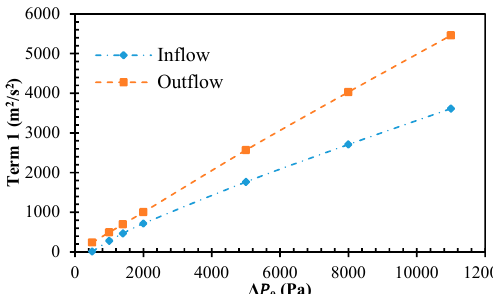
Figure 20. Comparison of the energy transfer Term 1 (changes in absolute velocity) of the outflow and inflow turbines.